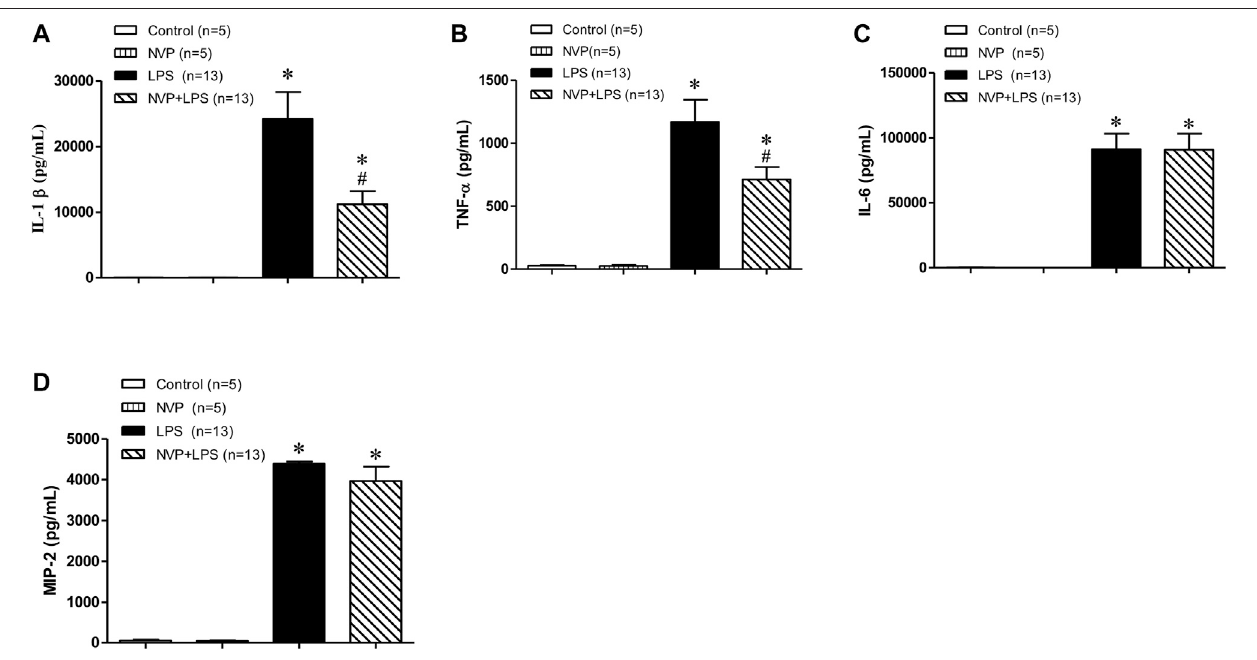
FIGURE 3 | Effects of NVP-AUY922 on pro-in fl ammatory cytokines. (A) Plasma cytokine IL-1 β . Effects of NVP-AUY922 on plasma levels of pro-in fl ammatory cytokineinterleukin-1 β (IL-1 β )6 hafterLPSadministrationinrats. (B) PlasmacytokineTNF- α .EffectsofNVP-AUY922onplasmalevelsoftumornecrosisfactor α (TNF- α ) 6 h after LPS administration in rats. (C) Plasma IL-6. Effects of NVP-AUY922 on plasma levels of pro-in fl ammatory cytokine interleukin-6 (IL-6) 6 h after LPS administration in rats. (D) Plasma MIP2. Effects ofNVP-AUY922 on plasma levels ofpro-in fl ammatory cytokine macrophagein fl ammatory protein (MIP-2) 6 h after LPS administration in rats. NVP: NVP-AUY922 5 mg/kg. Values are expressed as mean ± SEM. * p < 0.05 vs. Control group, # p < 0.05 vs. LPS